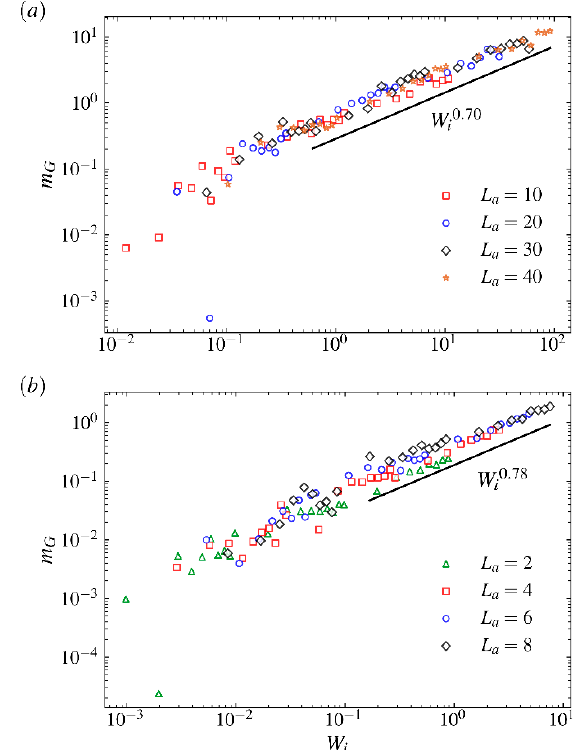
Figure 11. Orientational resistance parameter m G as a function of the Weissenberg number Wi for comb polymers with ( a ) long arms and ( b ) short